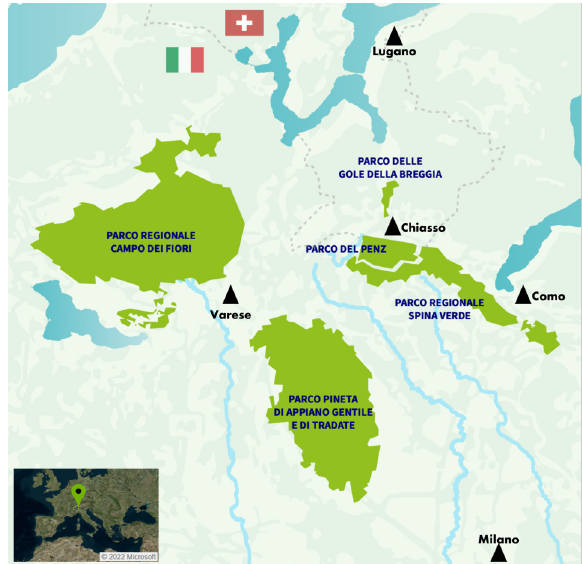
Figure 1. Schematic of the Insubria region with its parks (green polygons) and main urban centres (black triangles). Reference map background: Bing Satellite © 2022 Microsoft. Adapted from https://insubriparksturismo.eu.